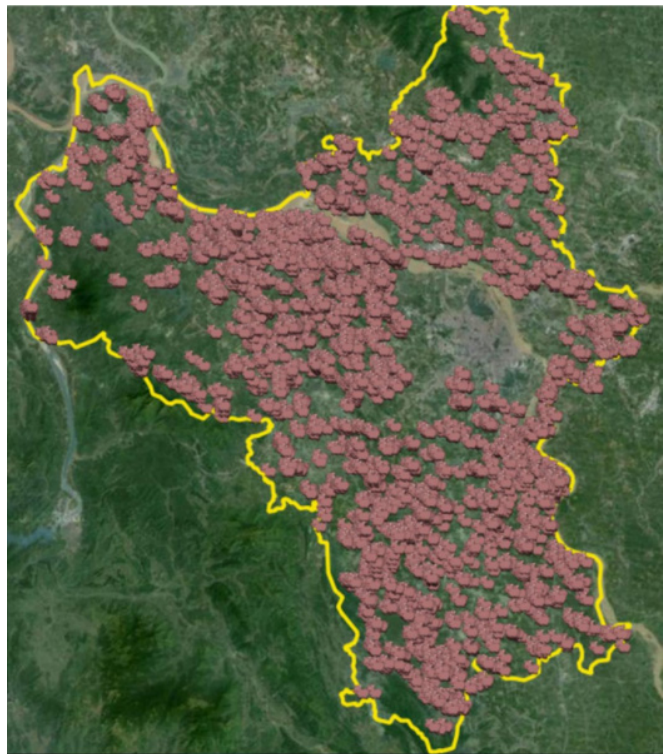
Figure 2. Geographical distribution of pig farms in Hanoi omitting the class of small farms (under 30 pigs) generated by QGIS.